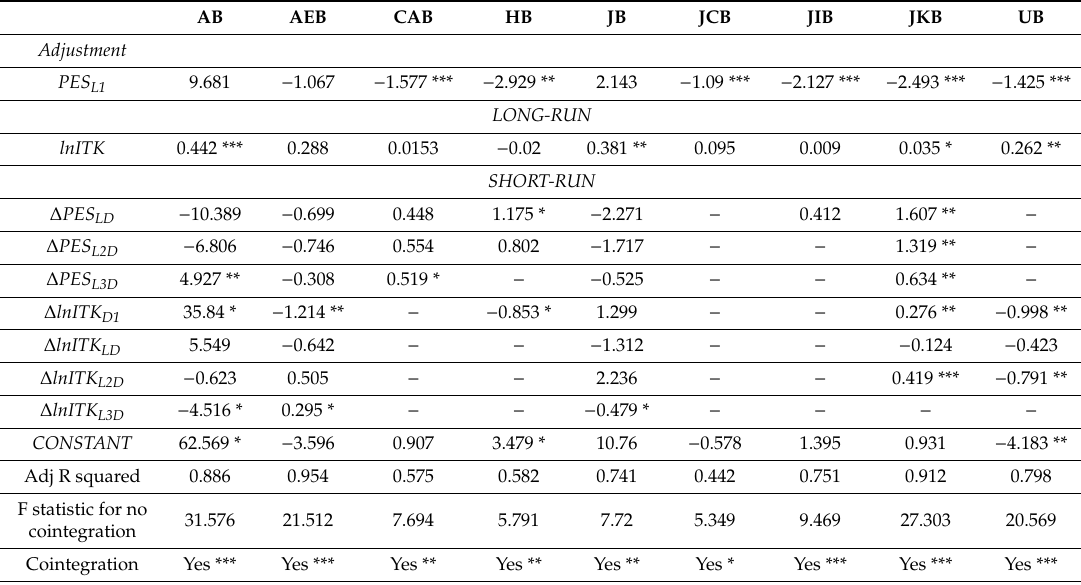
Table 7. Estimates of ARDL and ECM models for profit e ffi ciency score